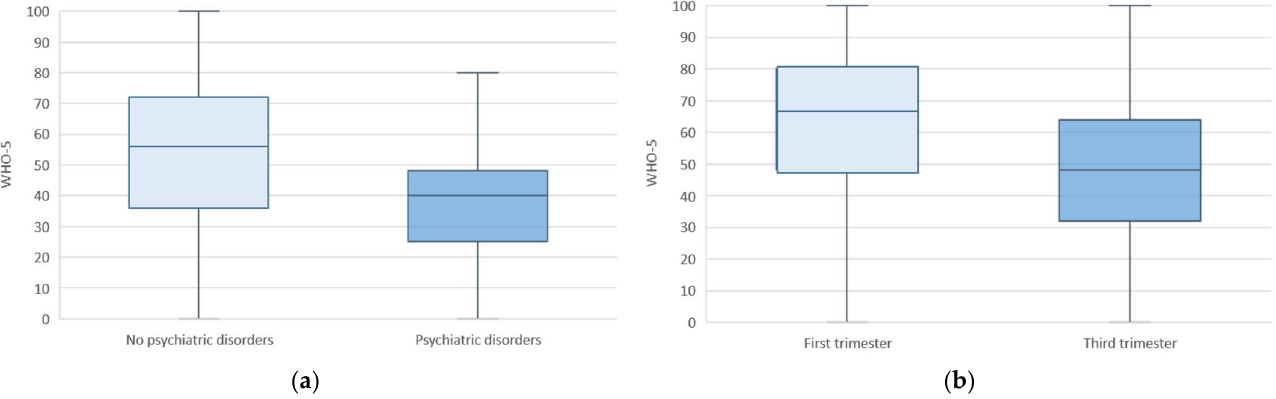
Figure 2. Maternal WHO-5 well-being outcomes for the pandemic cohort based on the presence of psychiatric disorders ( a ) and trimester of pregnancy ( b ). Regarding pregnancy and neonatal outcomes, being in the third trimester of pregnancy was significantly associated to worse maternal well-being (median (IQR) score 48 (I32–64) ( p < 0.001) (Figure 2b). This association was not seen for preeclampsia, prematurity, ce- sarean section, or fetal distress among others (Table